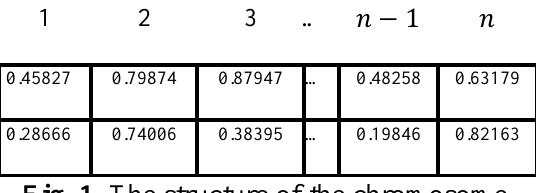
Fig. 1. The structure of the